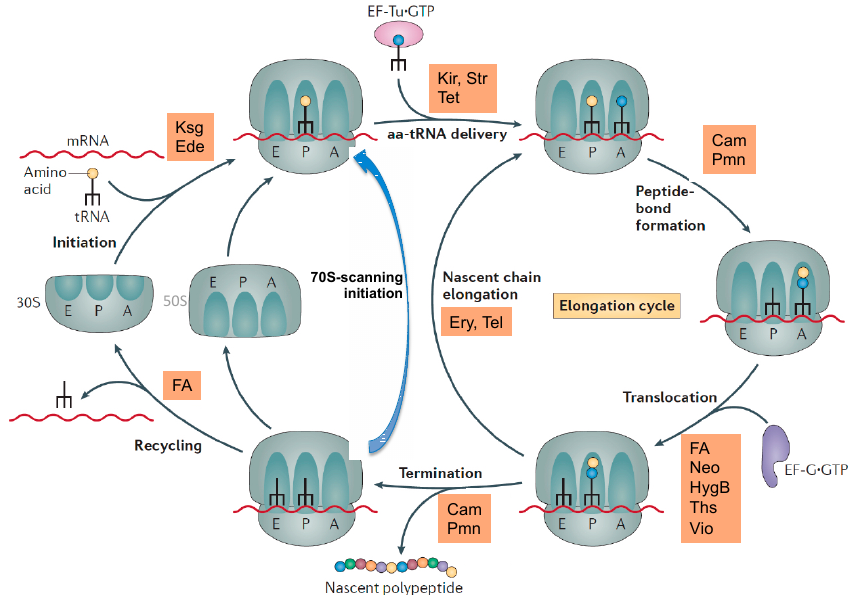
Figure 2. Overview of some antibiotics interfering with ribosomal functions. Kir, kirromycin; Str, streptomycin, tet, tetracycline; Cam, chloramphenicol; Pmn, puromycin; FA, fusidic acid; Neo, neomycin, HygB, hygromycin B; Ths, thiostrepton; Vio, viomycin; Ery, erythromycin, Tel, telithromycin. 70S-scanning initiation is a newly detected initiation mode in bacteria, which can replace the RRF/EF-G dependent recycling phase. Modified, from [11].